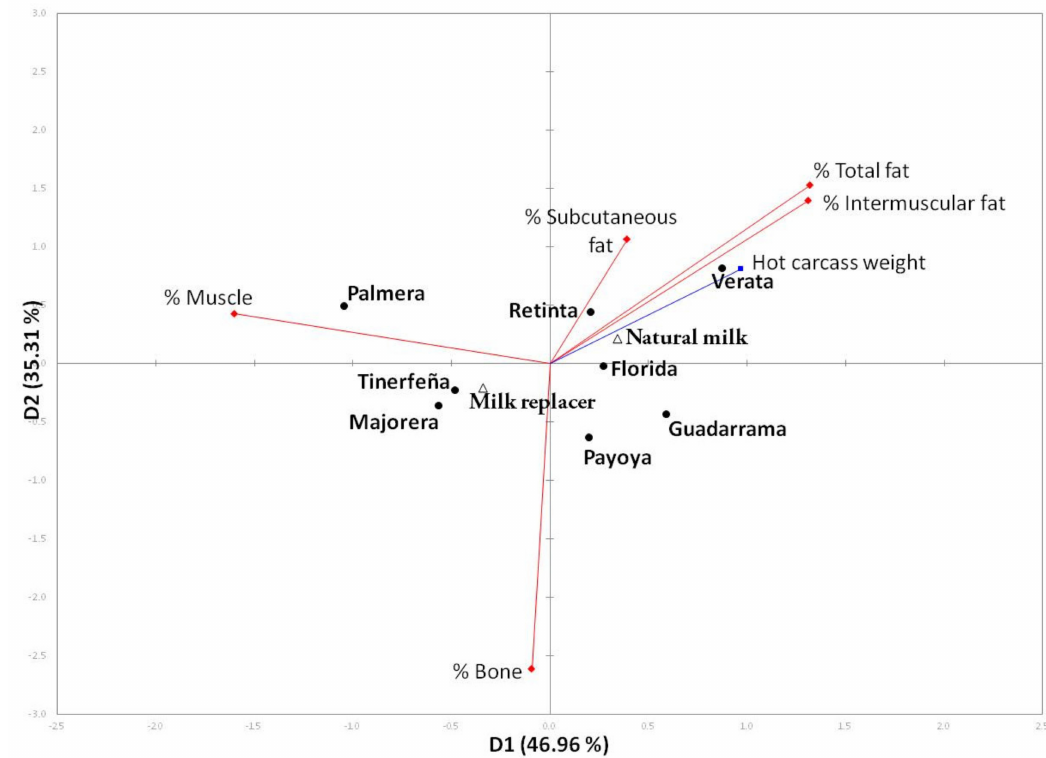
Figure 2. Biplot of the principal component analysis of tissue composition of forelimbs from kids reared with milk replacer (MR) or natural milk from their dams